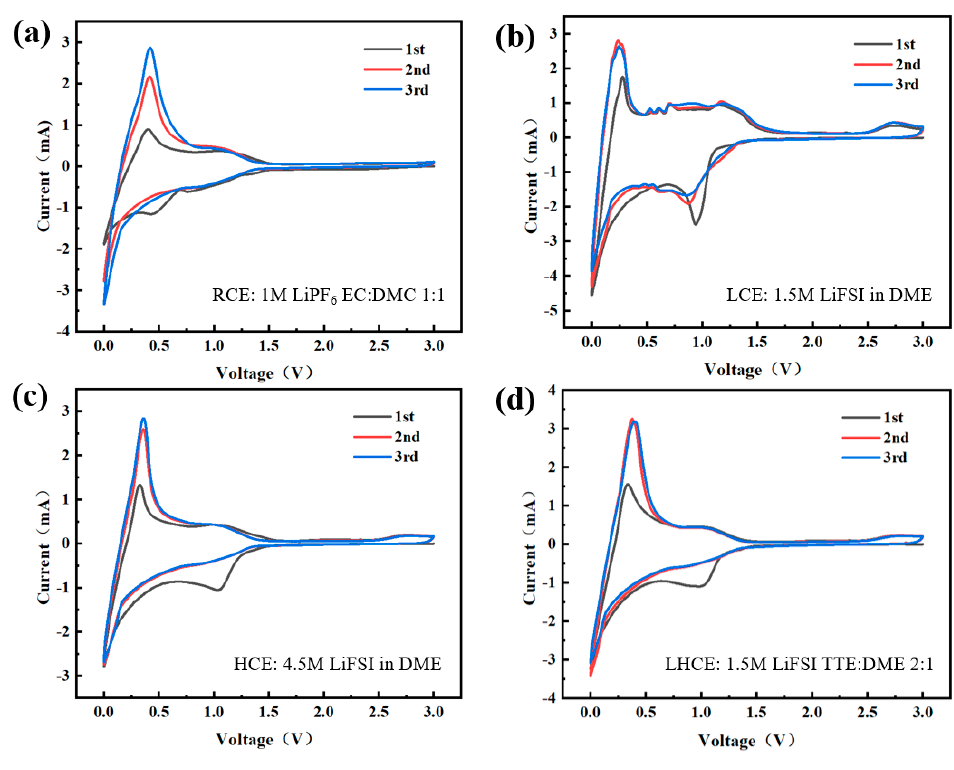
Figure 2. CV of Li||C batteries in ( a ) RCE, ( b ) LCE, ( c ) HCE, ( d ) LHCE.